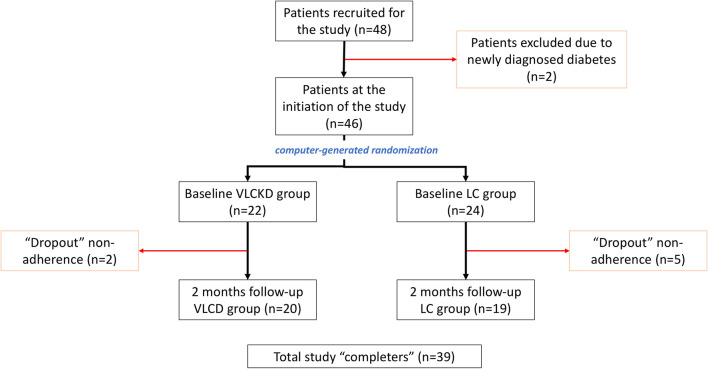
Study diagram describing the included population and groups.